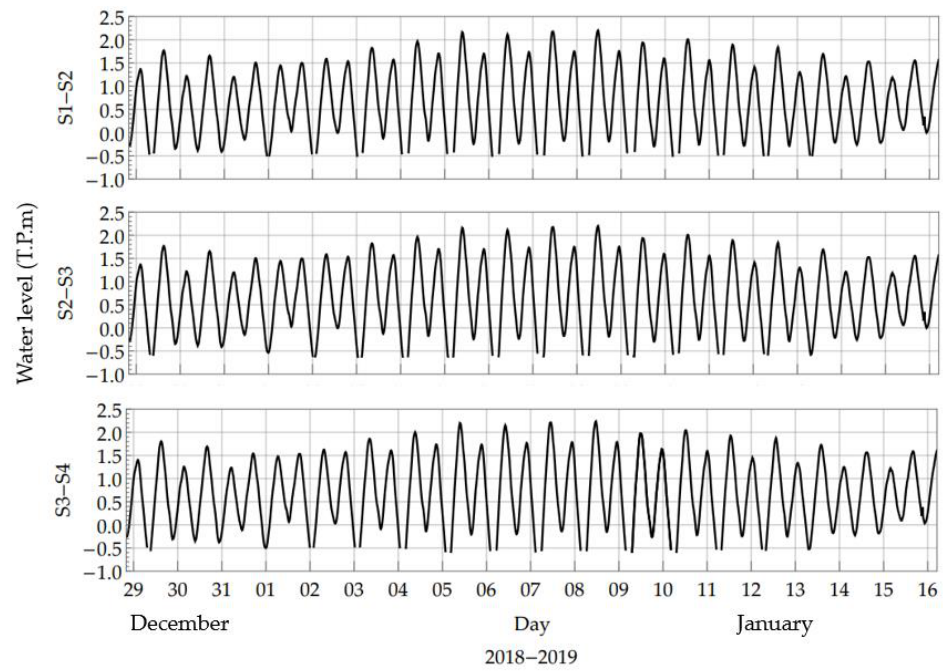
Figure 3. Temporal variations of water level during the study period recorded at the observed cross- sections.